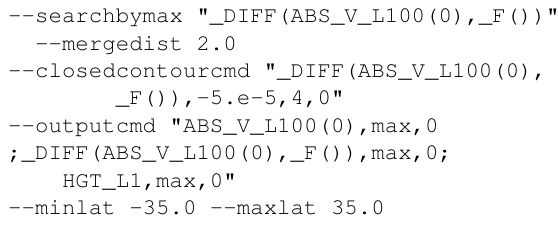
Figure 6. Extratropical cyclone counts within each 2 ◦ over the period 1979–2010, obtained using the procedure described in Sect.